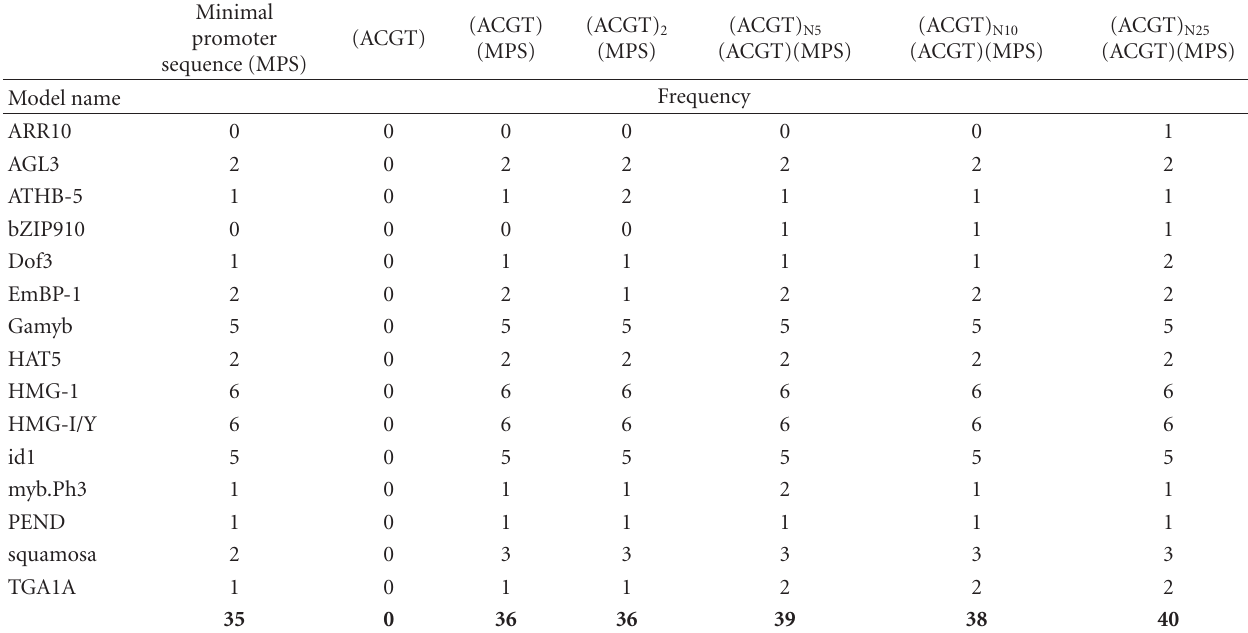
Table 3: Alterations in transcription factor binding sites when spacer sequence length between two ACGT palindromes is gradually increased from 5 to 25